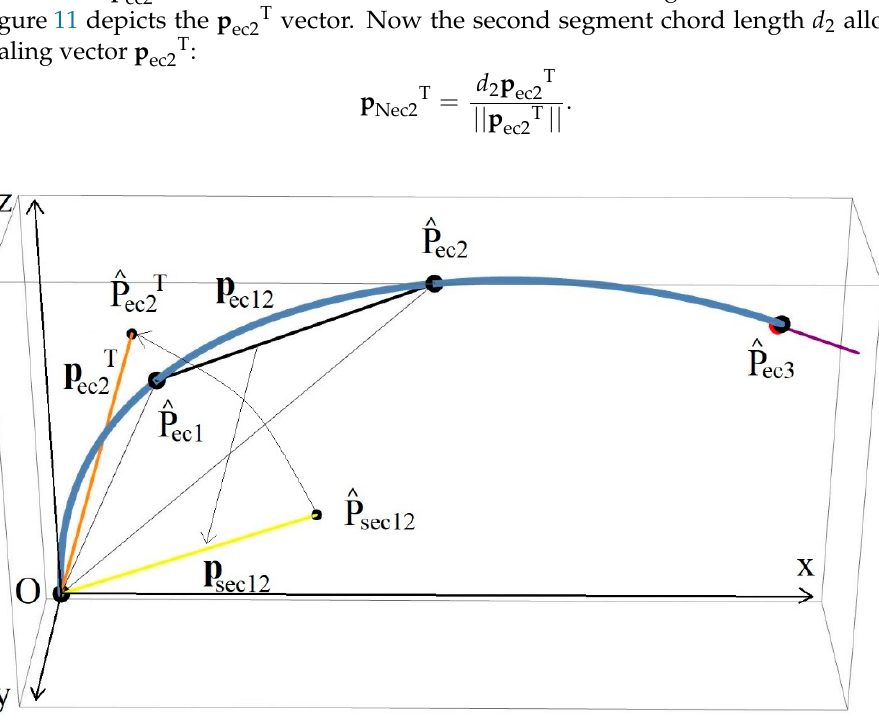
Figure 11. Second segment vector (cid:1816) (cid:2915)(cid:2913)(cid:2870)(cid:2904) calculation representation.